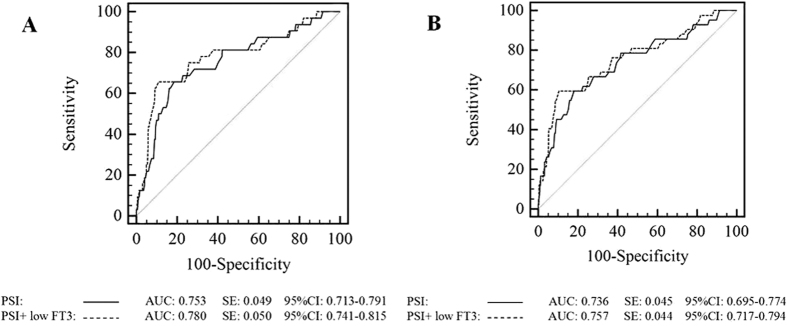
ROC curves for PSI and low FT3 + PSI for 30-day mortality (A) and ICU admission (B).